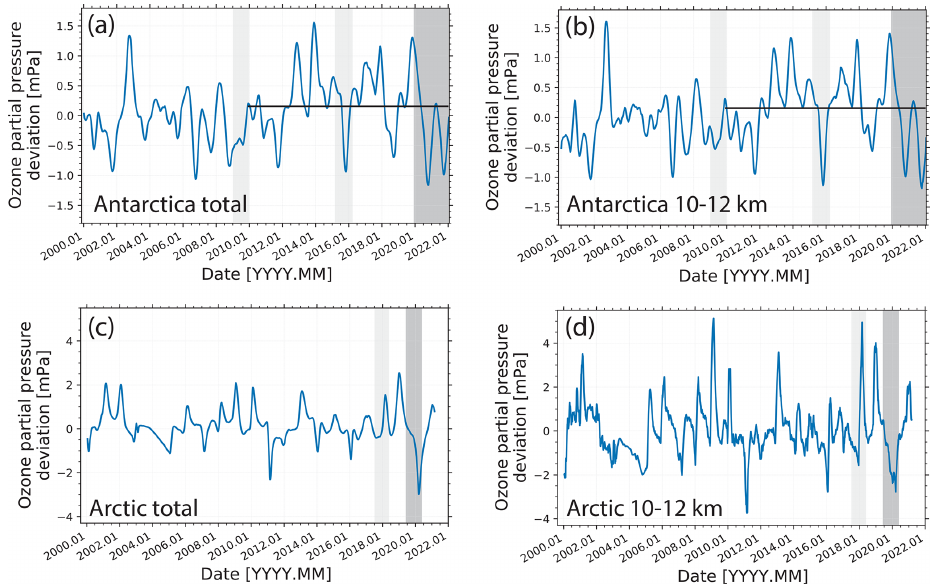
Figure 4. (a) Column ozone anomaly expressed as the difference between the monthly mean, vertical mean ozone partial pressure (0–35km height) and the respective climatological (2000–2019) monthly mean (Eq. 3). Ozone profiles measured at the Antarctic Neumayer and South Pole stations are considered; smoothing over five observations is applied. (b) Same as (a) for the 10–12km height range. (c) Same as (a) , except for ozone profiling at the Arctic Ny-Ålesund station. (d) Same as (c) for the 10–12km height range. Dark gray columns mark the time periods with strong stratospheric aerosol perturbations after the major Australian fire events (Black Summer, in a and b ) and Siberian fires (in c in d ). Light gray columns indicate time periods after the Australian fires in 2009 (Black Saturday, in a and b ) and the Calbuco volcanic eruption in April 2015 (in a and b ) and the Canadian fires (in c and d , period of influence from August 2017 to January 2018). The horizontal lines (a, b) emphasize the change in average ozone level, possibly caused by the healing of the ozone layer during the last